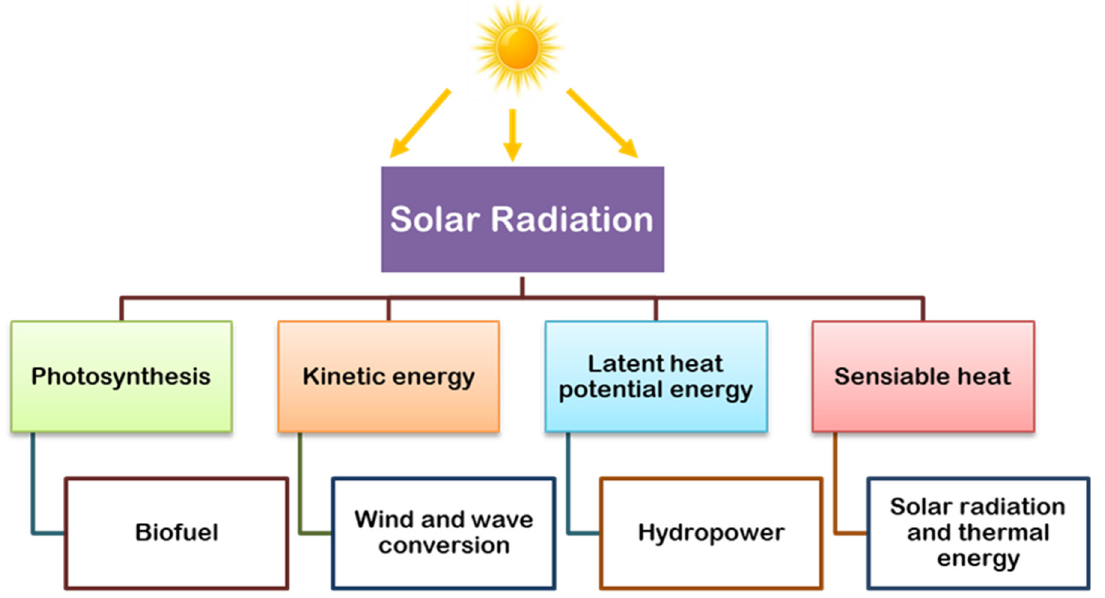
Figure 1. Solar radiation as the main source of renewable energies on Earth.